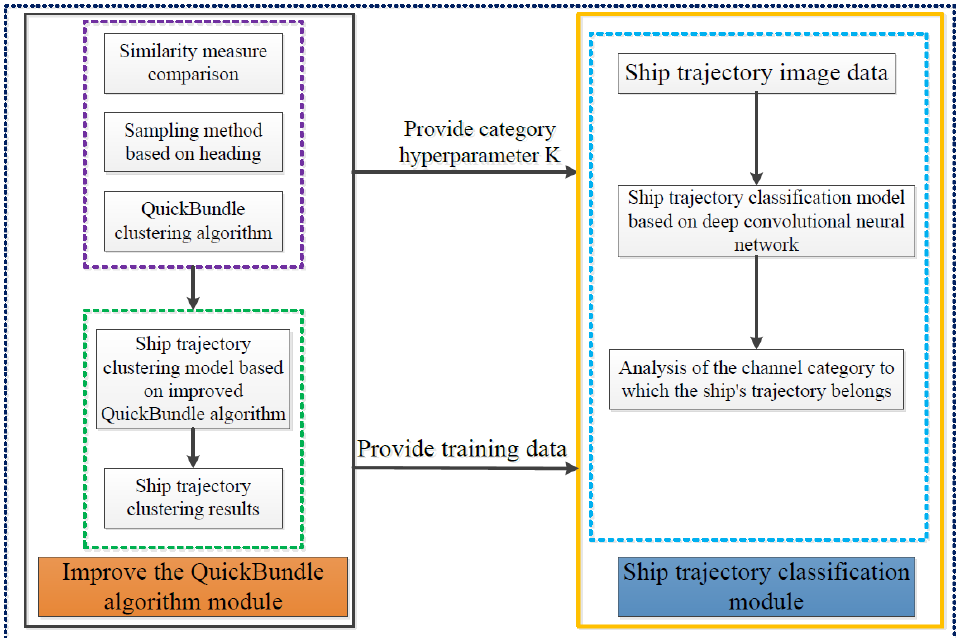
Figure 1. The working process of the proposed methodology.